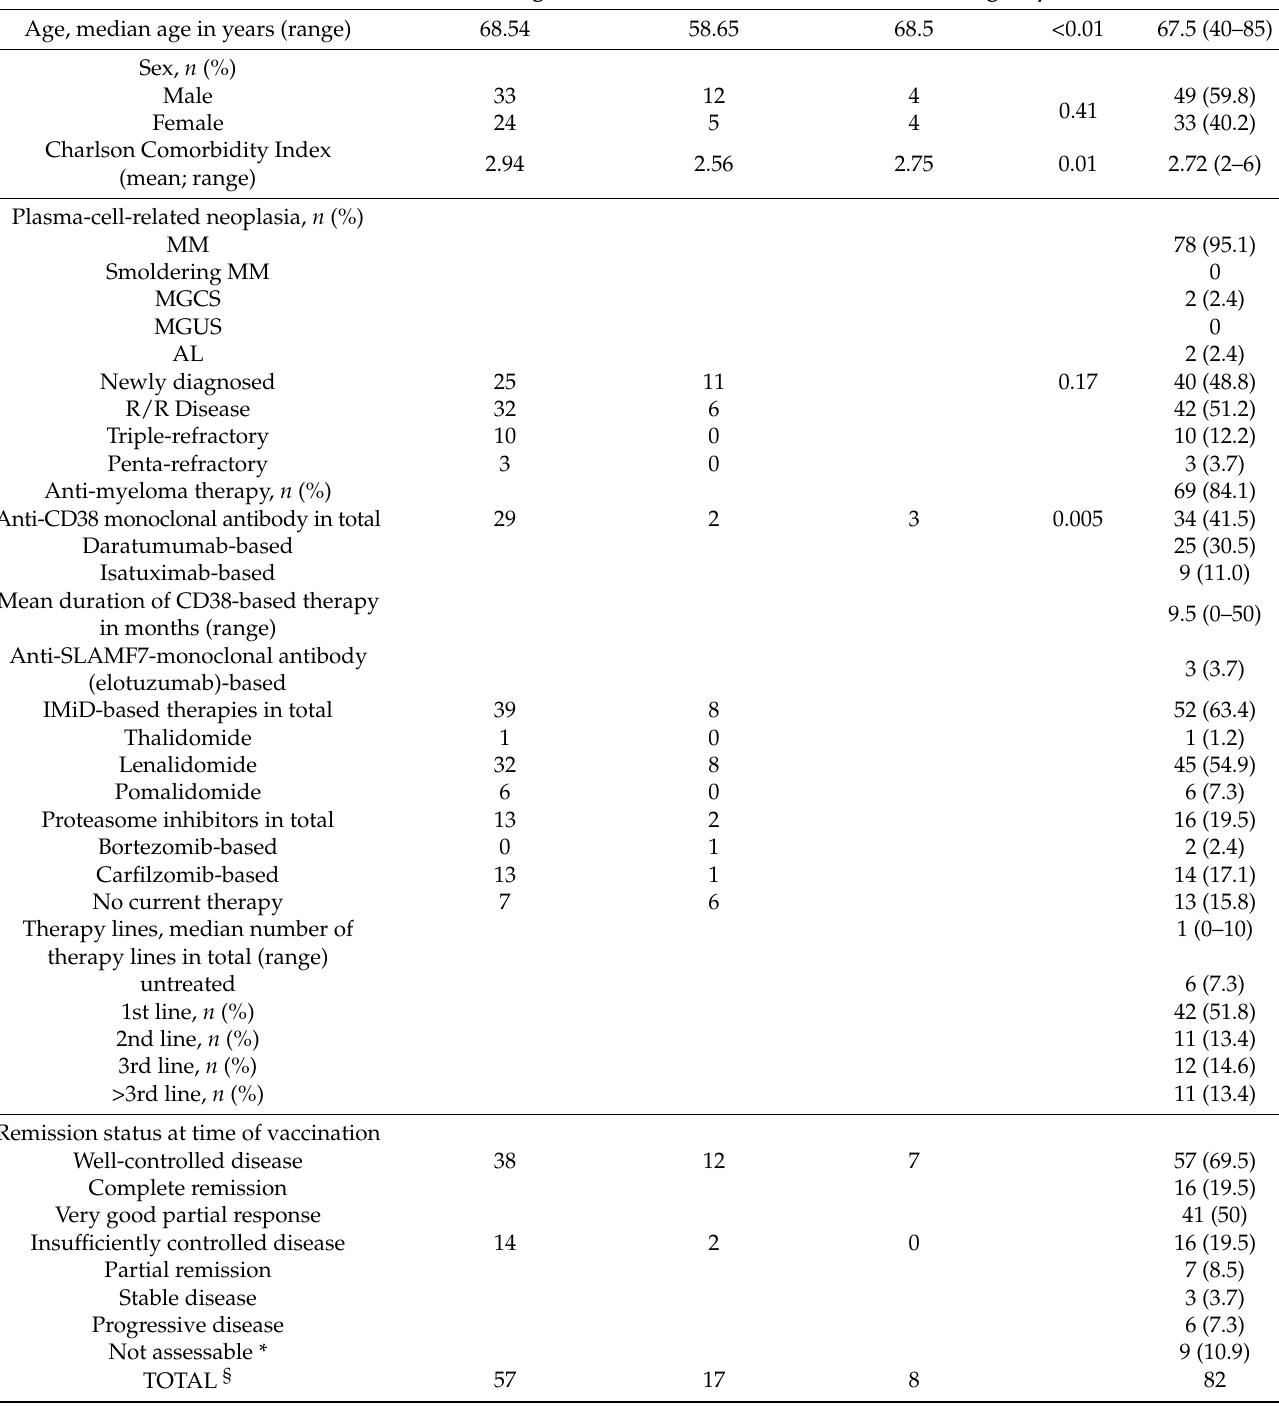
Table 1. Patient demographics and characteristics regarding plasma-cell-related disease and anti-myeloma treatment. Variable SP-AbT Negative SP-AbT Positive SP-AbT Missing Age, median age in years